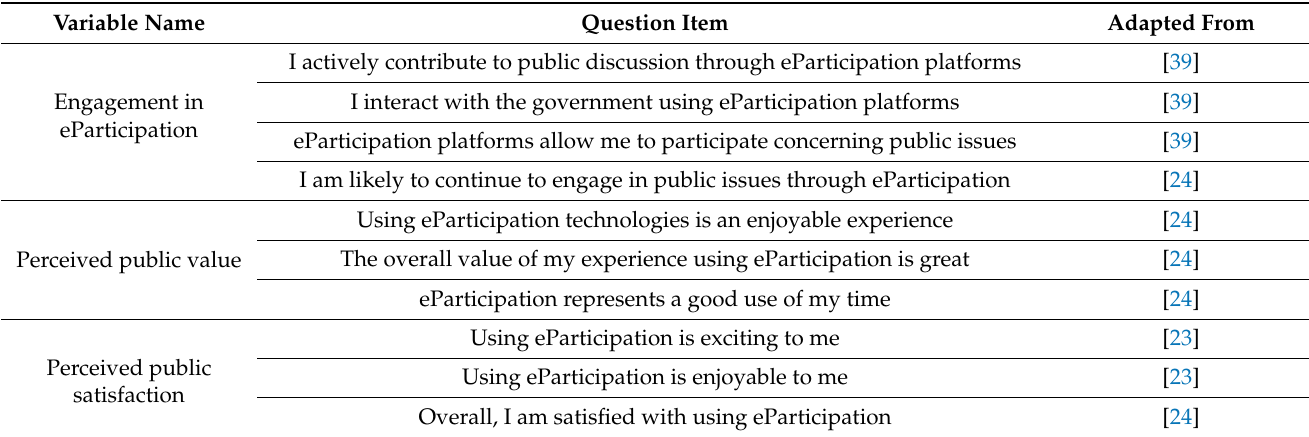
Table 1. Measurement question item